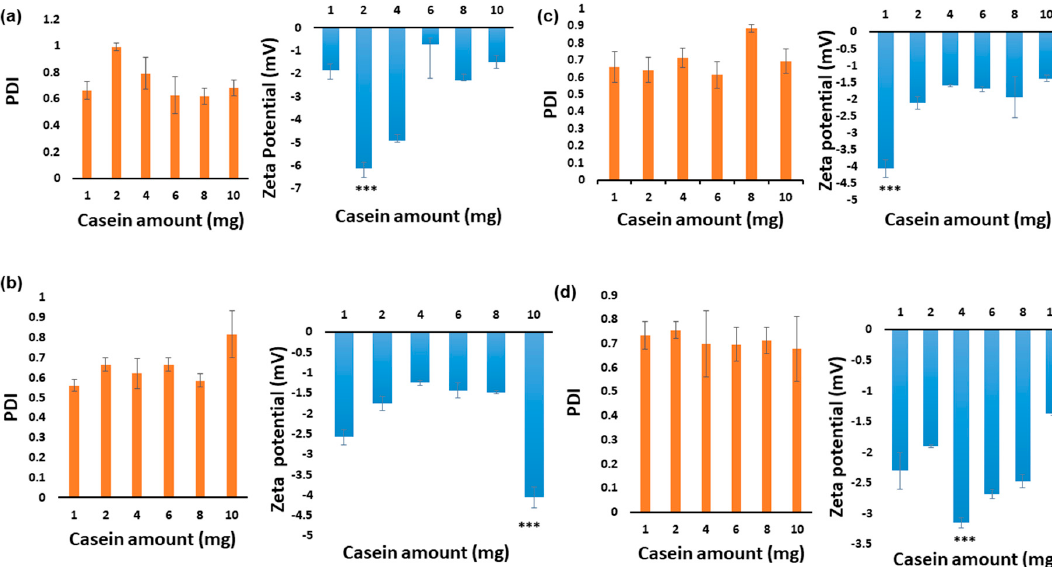
Figure 2. Comparative analysis of polydispersity index (PDI) and size of NaCNs prepared with 1, 2, 4, 6, 8 and 10 mg/mL of sodium caseinate and at ( a ) one hour ( b ) two hours ( c ) four hours ( d ) eight hours of mixing time, values were found very significant at p < 0.001 (***).